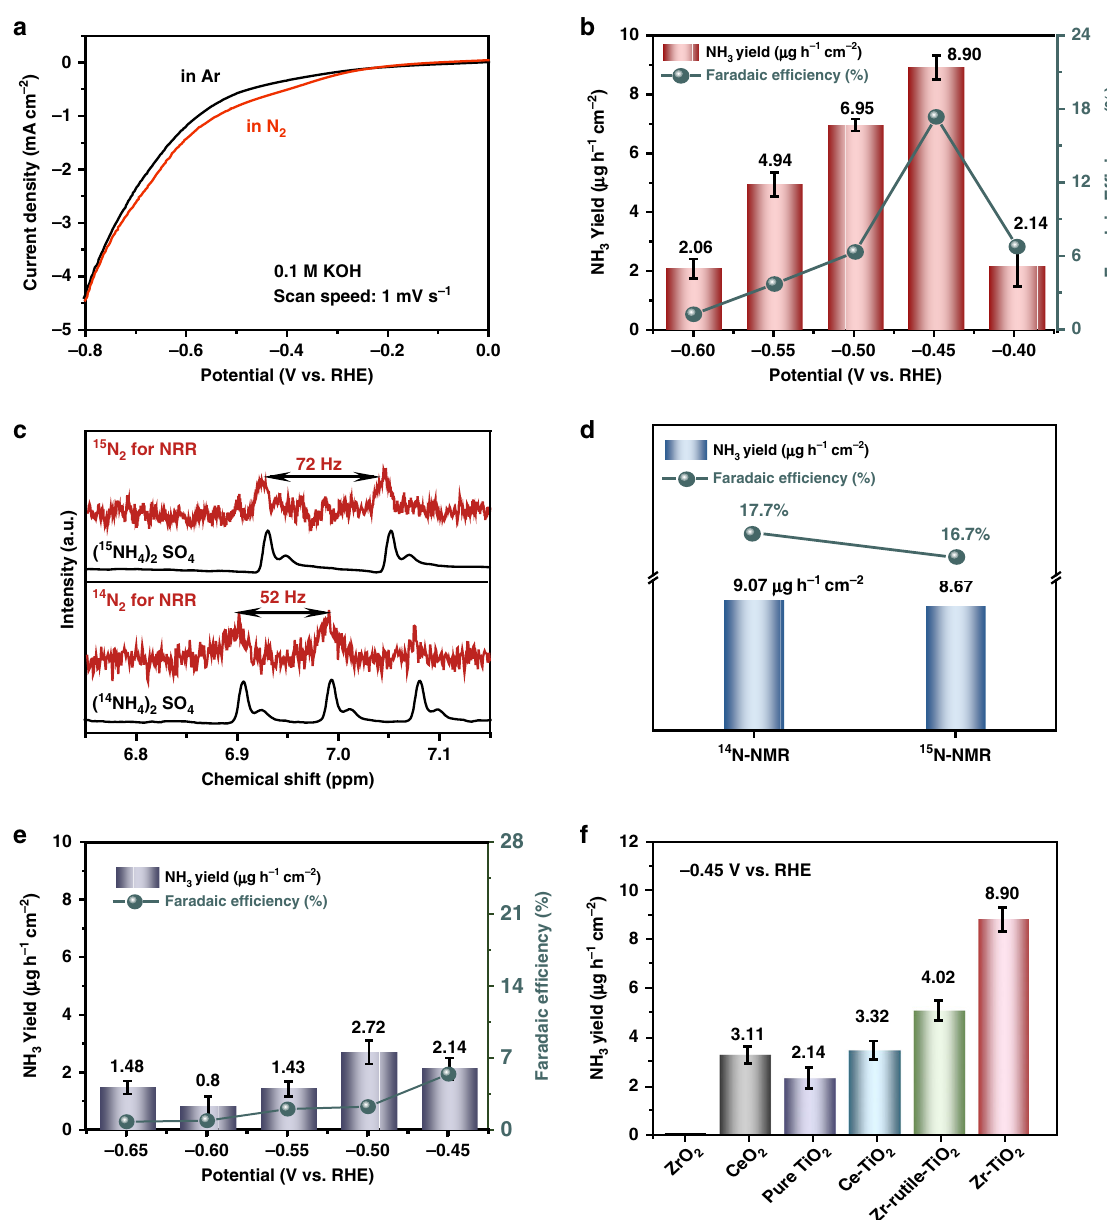
Fig. 7 Electrochemical N 2 fi xation. a Linear sweep voltammetric curves in N 2 -saturated (red line) and Ar-saturated (black line) electrolytes. b Yield of NH 3 production (red bars, left y axis) and Faradaic ef fi ciency (green dots, right y axis) of Zr-TiO 2 at each given potentials. c 1 H nuclear magnetic resonance (NMR) analysis of the electrolyte fed by 15 N 2 (upper panel) and 14 N 2 (lower panel) after the electrolytic reactions. d Comparison of the ammonia yield rate (blue bars) and NH 3 Faradaic ef fi ciencies (FE NH3 , green dots) using different feeding gases for the N 2 RR at − 0.45 V vs. RHE. e Yield of NH 3 (blue bars, left y axis) and FE y axis) of undoped TiO − 0.45 V vs. RHE. (Source NH3 (green dots, right 2 at each given potentials. f Yields of NH 3 with different catalysts at data are provided as a Source Data fi